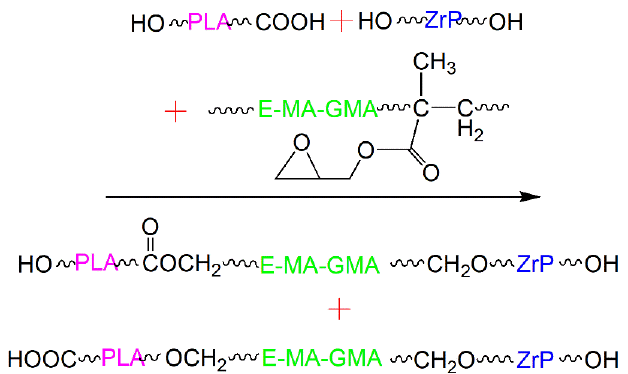
Figure 1. The reaction principle during melt − mixing between PLA, ZrP, and E − MA − GMA.